Question: Condense the content of this figure into a single sentence.
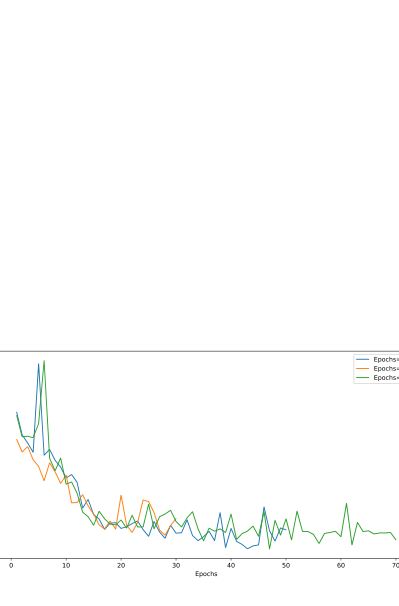
Answer: Loss under different Epochs.